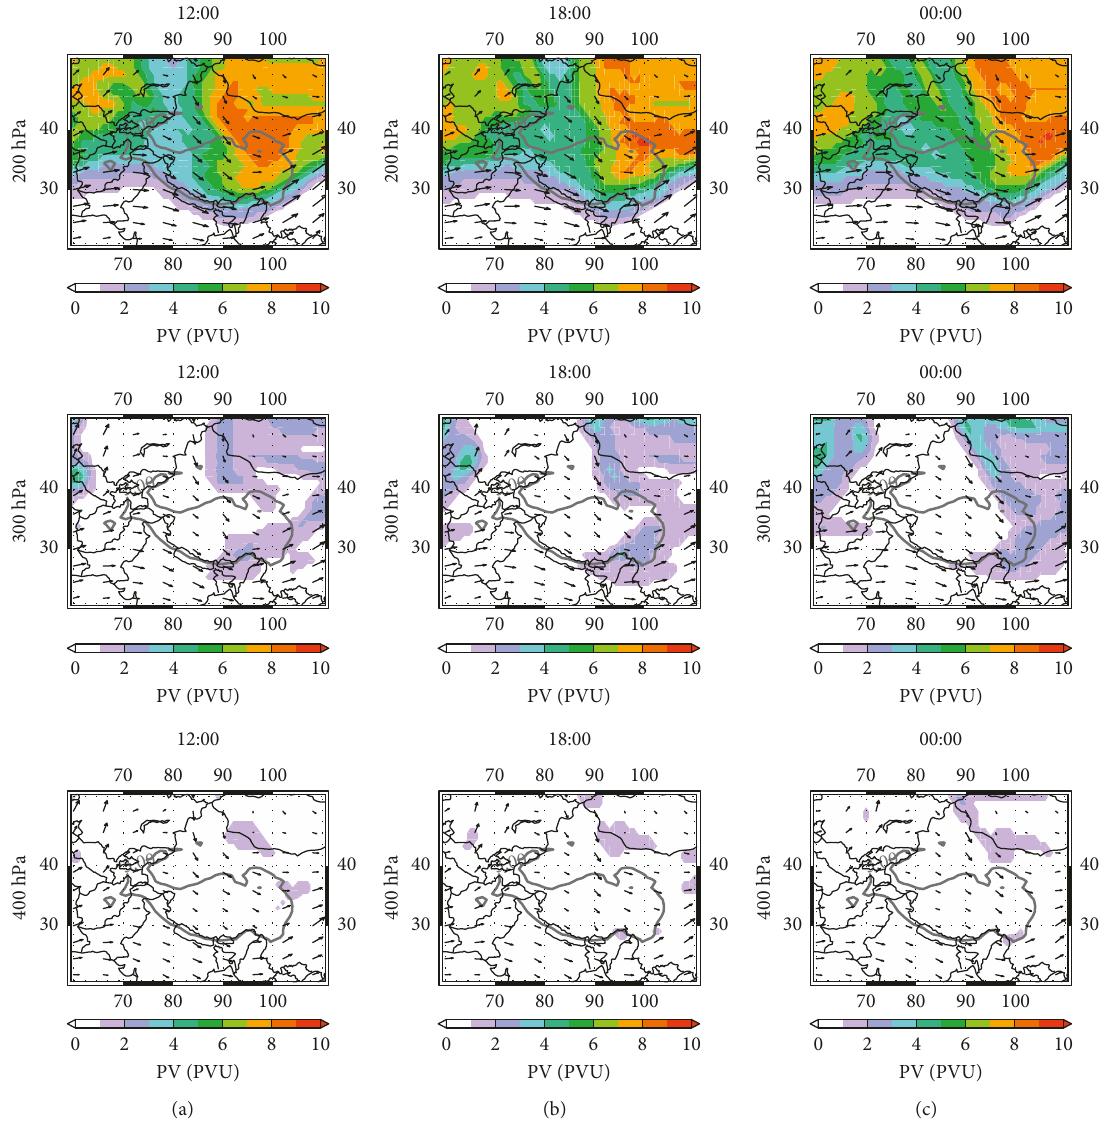
Figure 11: PV (color shadings; pvu) and wind field (vectors; m/s) at 200hPa (upper), 300hPa (middle), and 400hPa (lower) at 12:00 UTC 29 December 2018 (a), 18:00 UTC 29 December 2018 (b), and 00:00 UTC 30 December 2018 (c). Gray contours indicate the location of the TP (3km